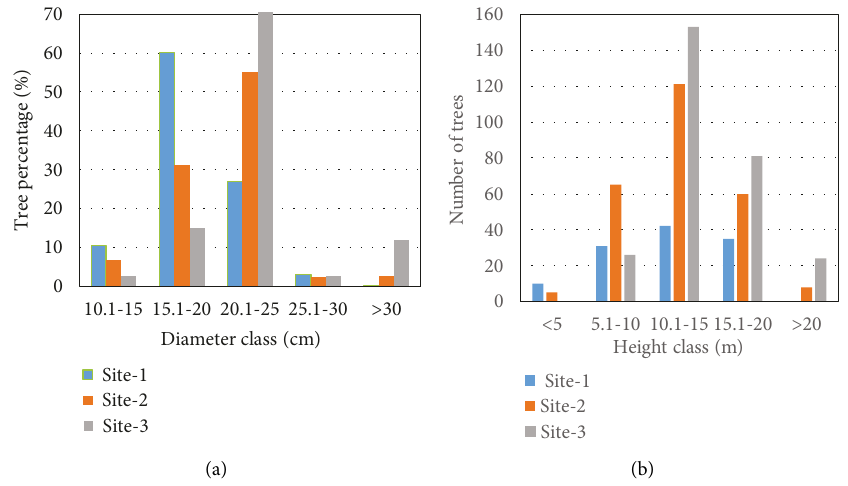
Figure 7: Distribution of trees based on DBH class (cm) and height class ( m ) of three sites of the study Table 9: Relative density, relative frequency, relative dominance, and important value index (IVI) of the enlisted mature tree species of all three sites.